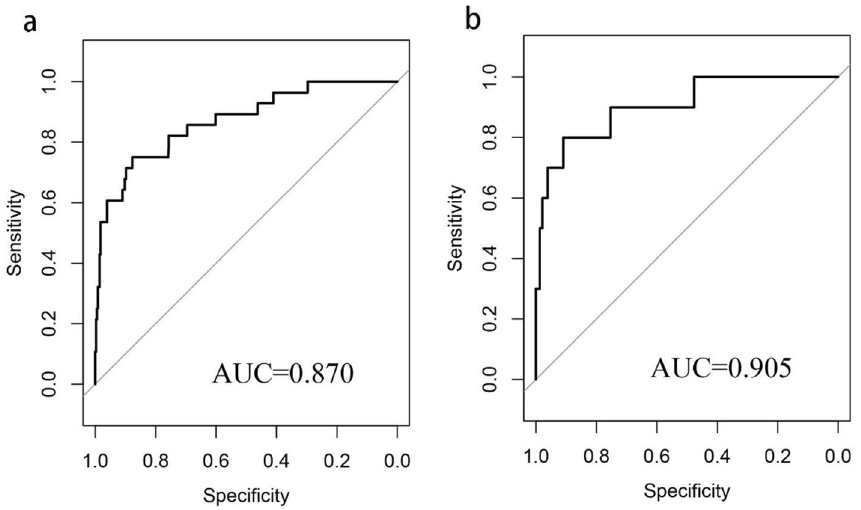
Figure 3. Comparison of the receiver operating characteristic curve (ROC) of the nomogram in the training cohort ( a ) and the validation cohort ( b ). The area under curve (AUC) were positively correlated with the predictive accuracy of the nomogram.